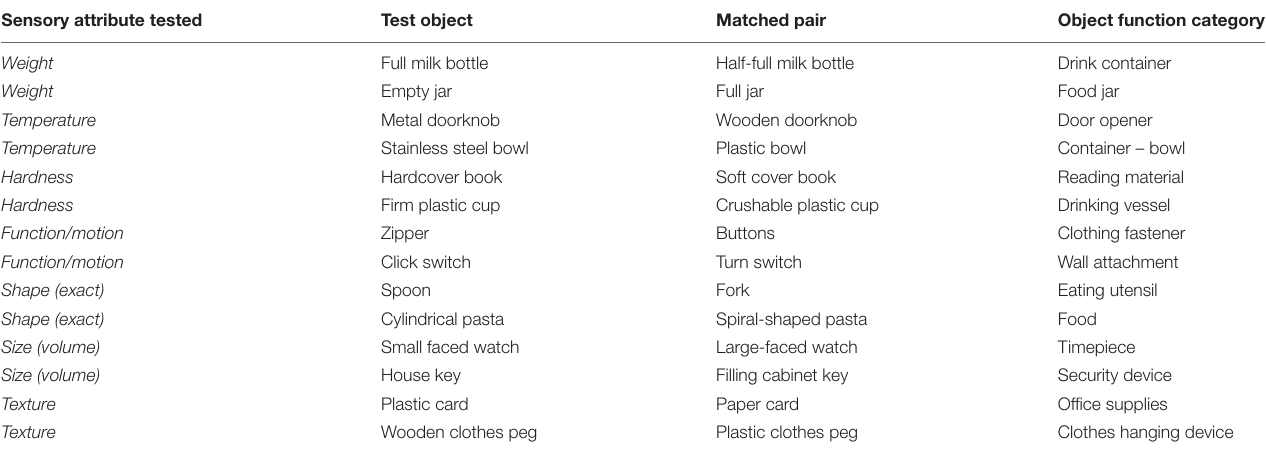
TABLE 1 | Somatosensory attribute sampled and corresponding test objects and object function category. Sensory attribute